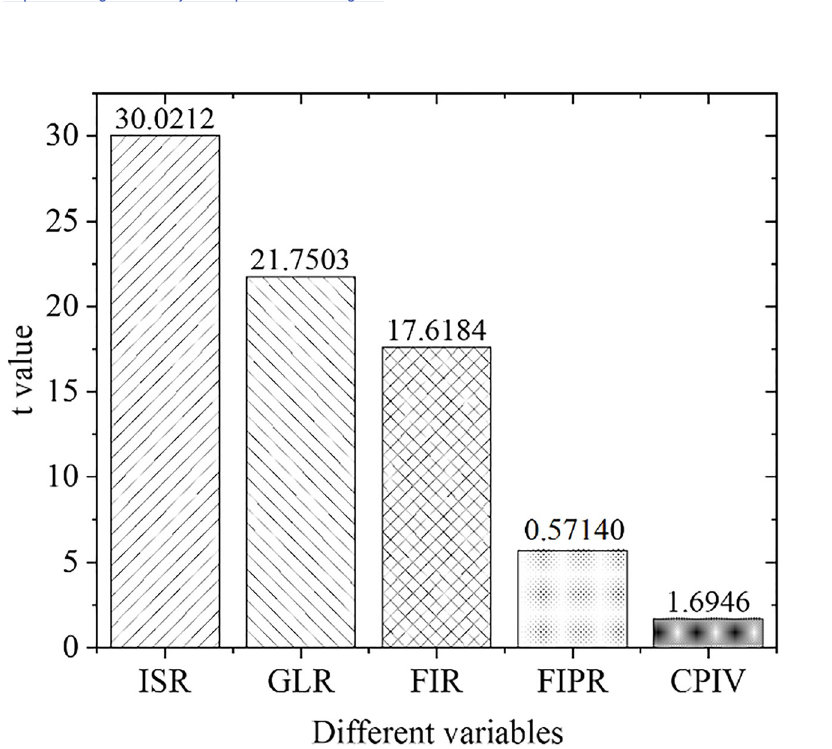
Fig 14. Robustness analysis results (t-value of the whole country).